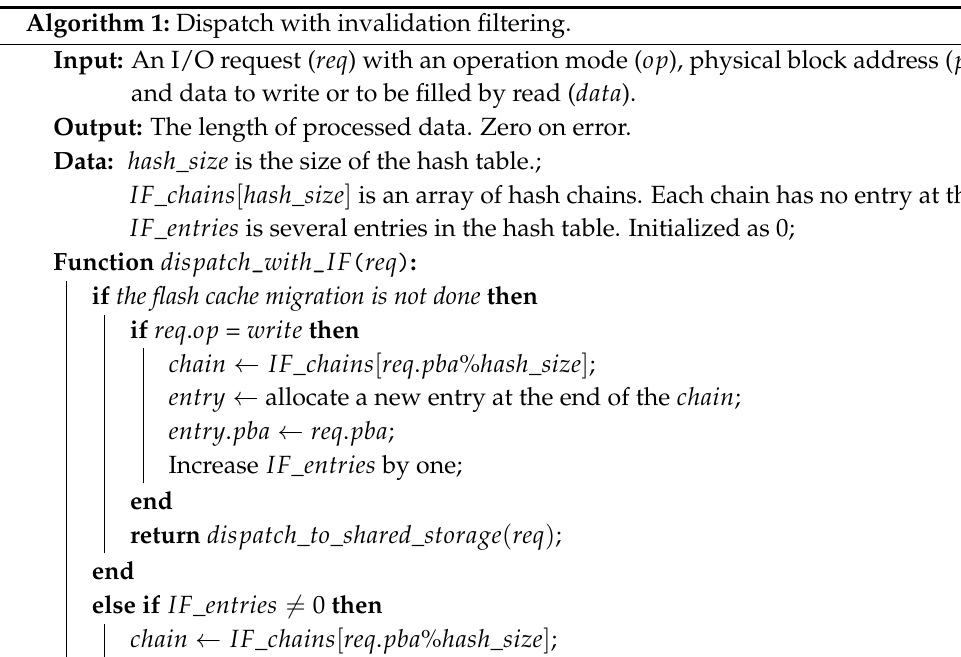
Algorithm 1: Dispatch with invalidation